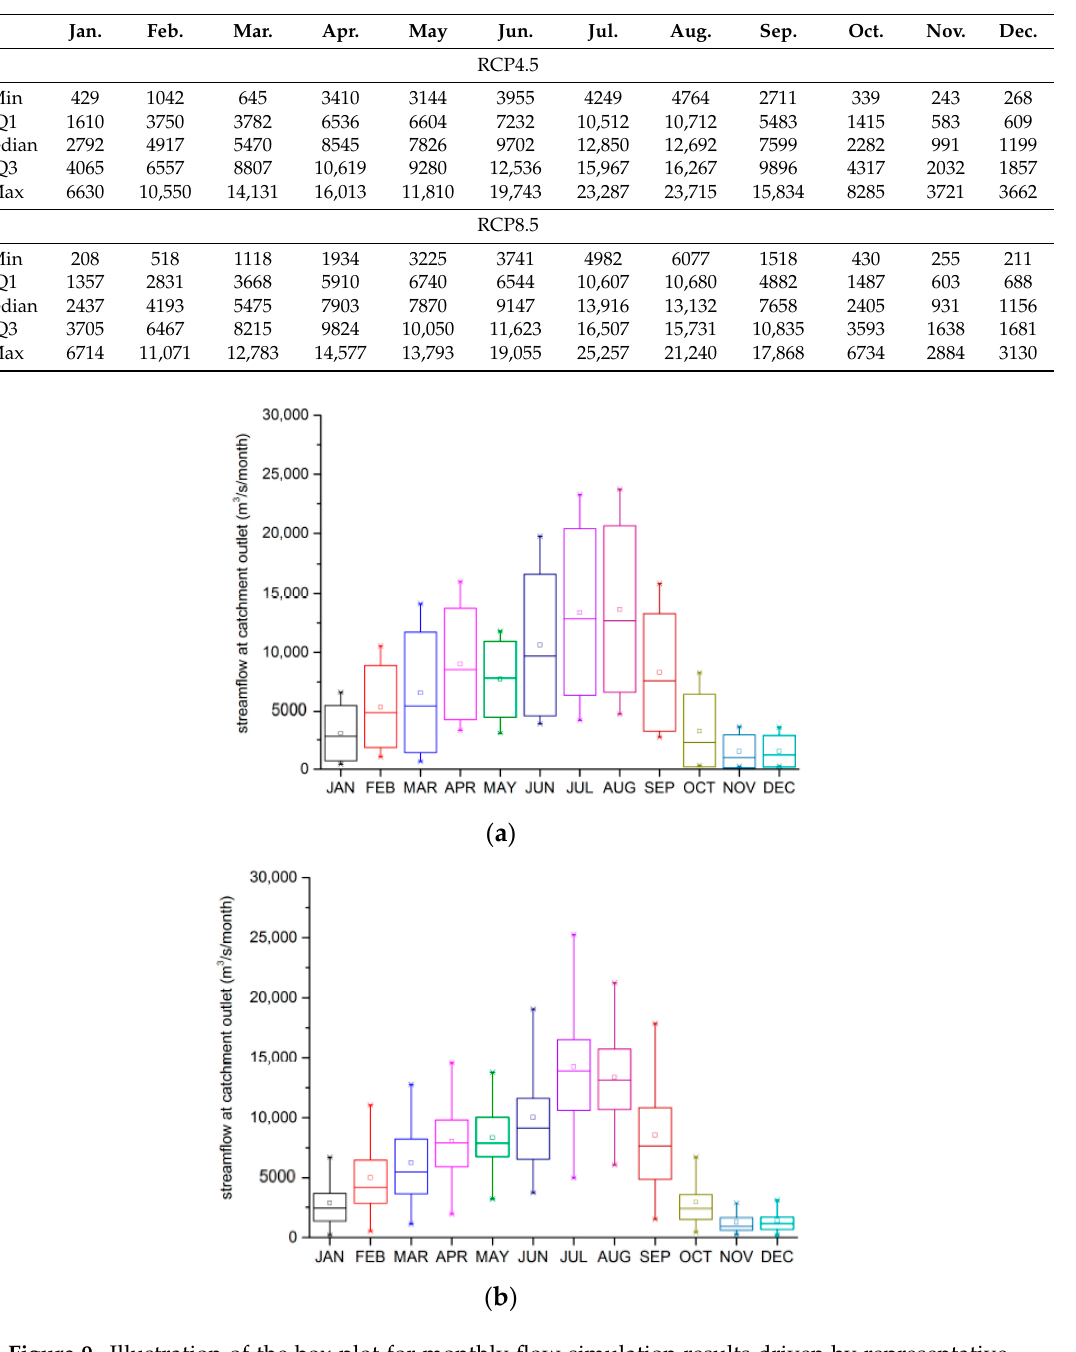
Figure 9. Illustration of the box plot for monthly flow simulation results driven by representative concentration pathways (RCP) rainfall in the LXH model ( a : RCP4.5; b : RCP8.5).